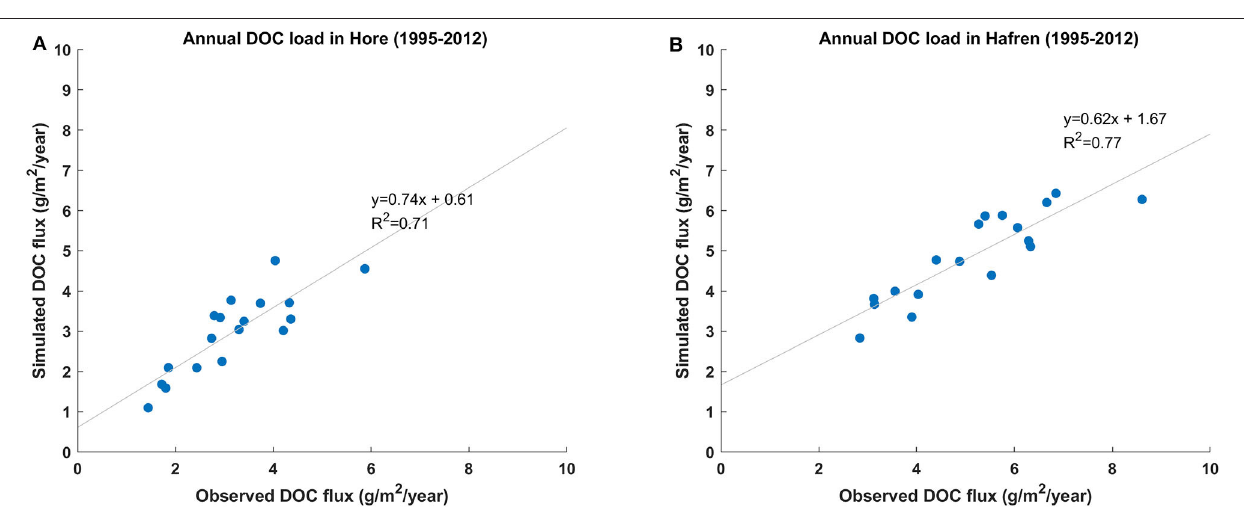
FIGURE 7 | Simulated and Observed Annual DOC load at Hore (A) and Hafren (B)